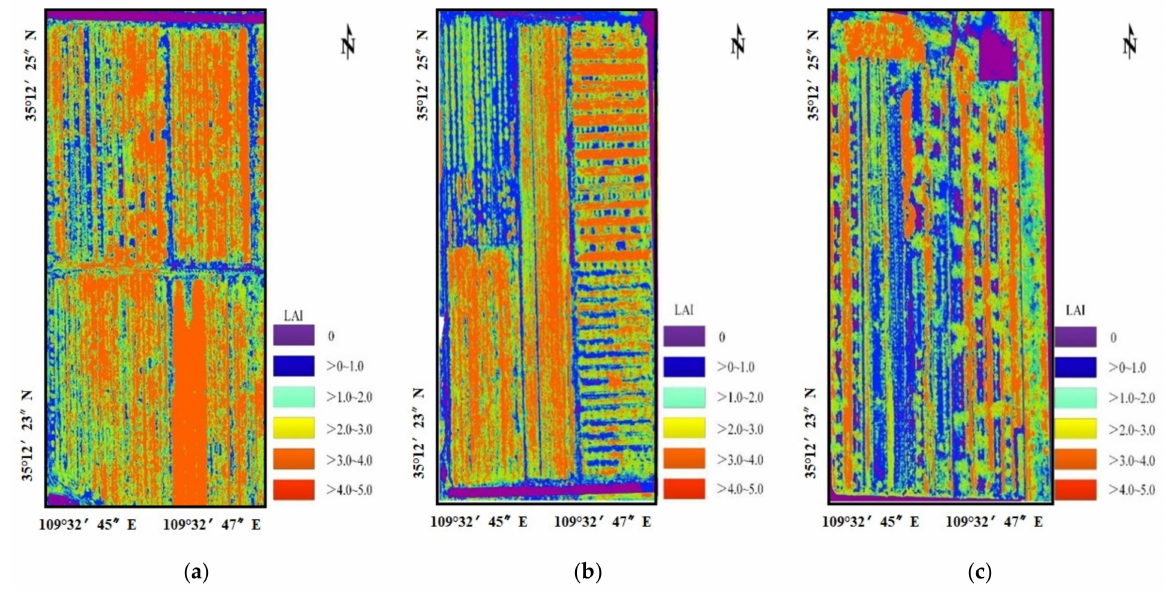
Figure 10. Remote-sensing maps of the apple trees during the leaf differentiation stage: ( a ) the Fuji apple trees; ( b ) the Golden Delicious apple trees; ( c ) the Ruixue apple trees.